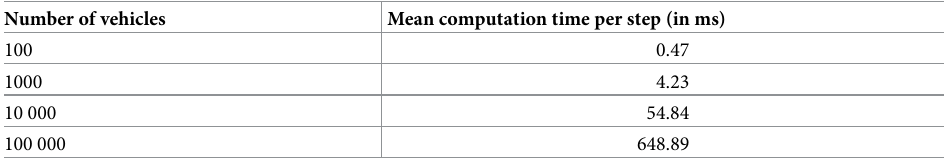
Table 9. Computation time according to the number of vehicles.